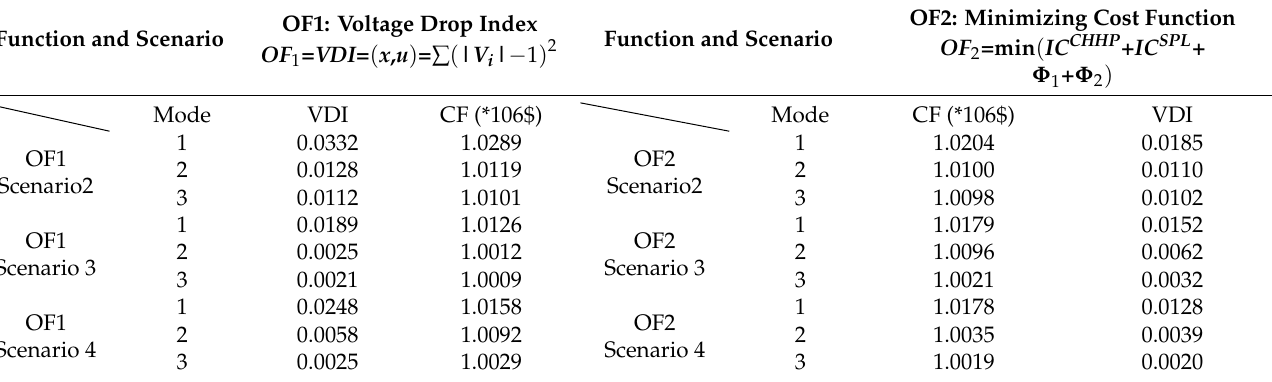
Table 5. Given solution by employing TOPSIS.